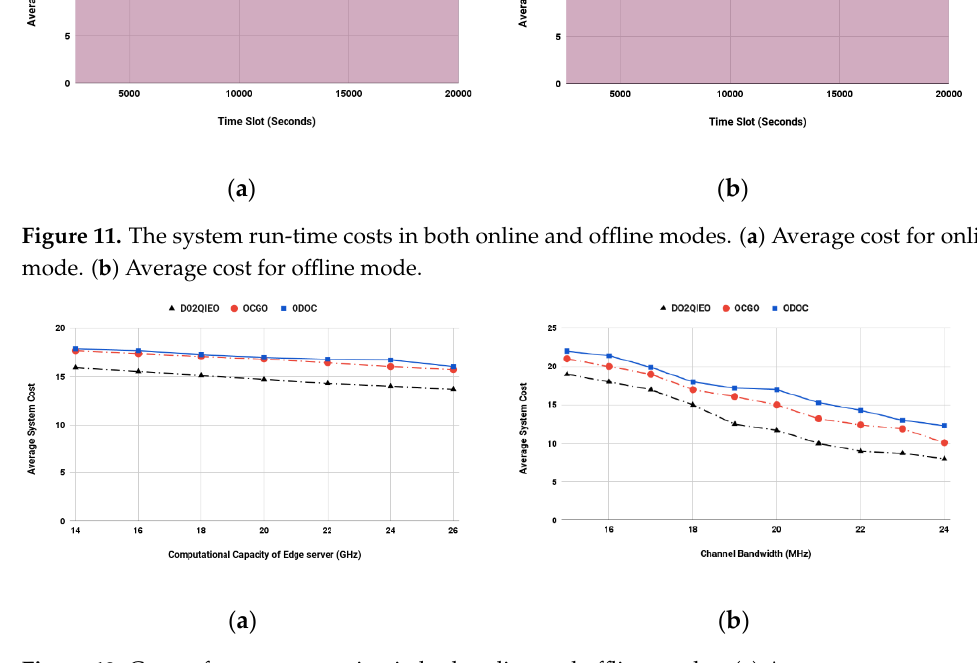
Figure 12. Costs of system operation in both online and offline modes. ( a ) Average system cost for given edge server computation; ( b ) Average system cost for given channel bandwidth (Figure ( a ) is on the left, Figure ( b ) is on the right ( b )).